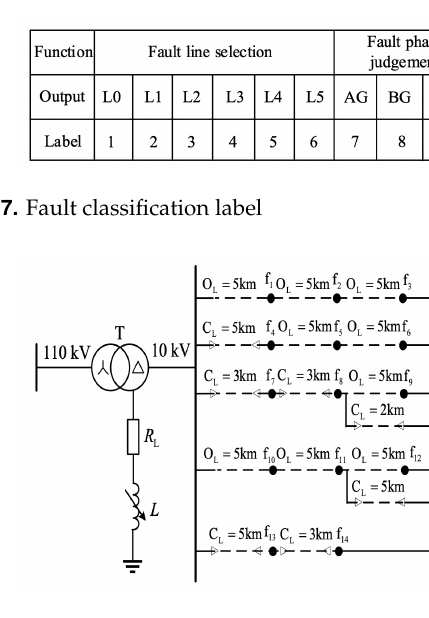
Fig. 8. Simulation model of grounding